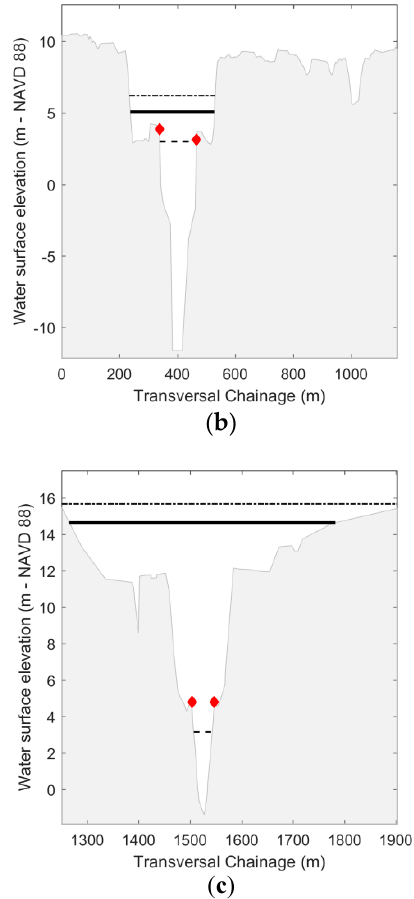
Figure 7. Similar to Figure 6 but in the transverse direction at stations HM ( a ), HTB ( b ) and HBB ( c ). The location of the bank stations is extracted from the regulatory HEC-RAS riverine flood model and roughly indicates the change in channel conveyance.